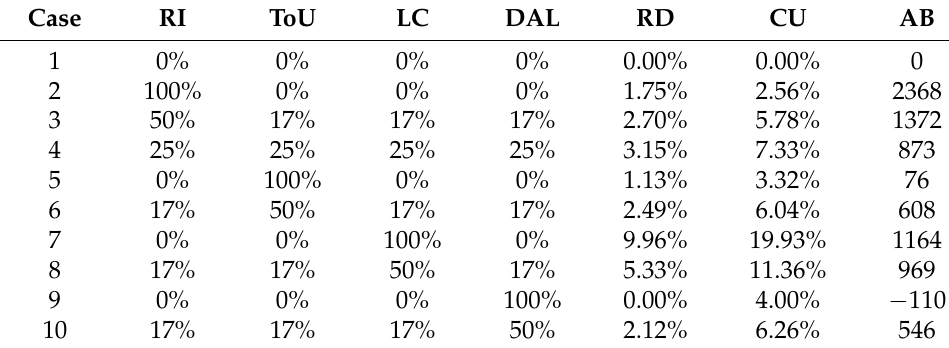
Table 2. Results of the simulations in the peak scenario.